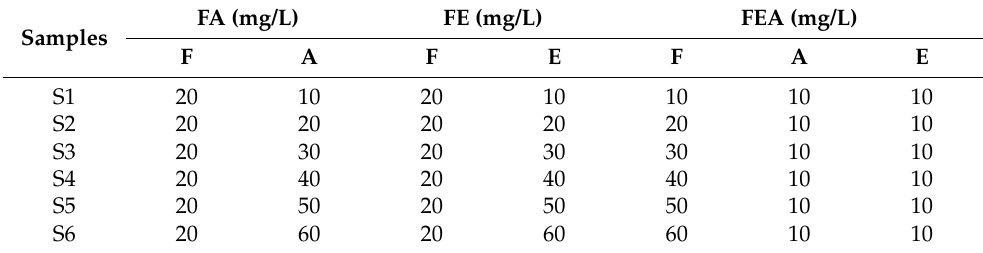
Table 2. Combined dosage ratio of the